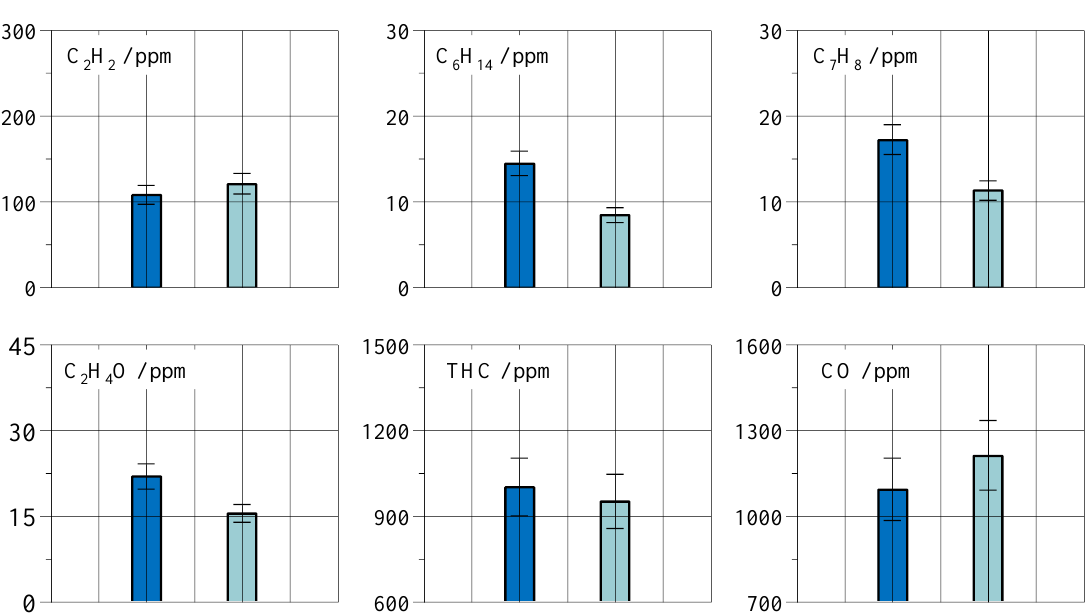
Figure 9. Measured species of near-wall gas sample of the GSV at n = 2000 1/min and IMEP = 12 bar.